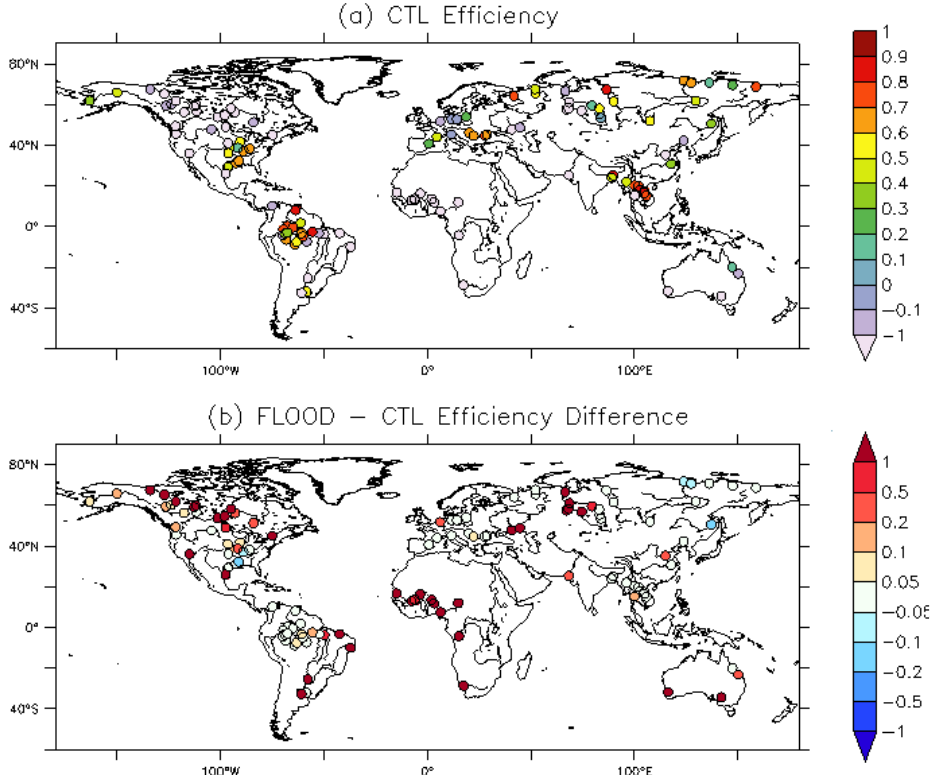
Fig. 6. Validation of the ISBA/TRIP simulation with in situ discharge measurements using the 1986–2006 period. (a) Efficiency of the original simulation (without flood parameterization). (b) Variation of the efficiency when the flood coupling between ISBA and TRIP is activated.